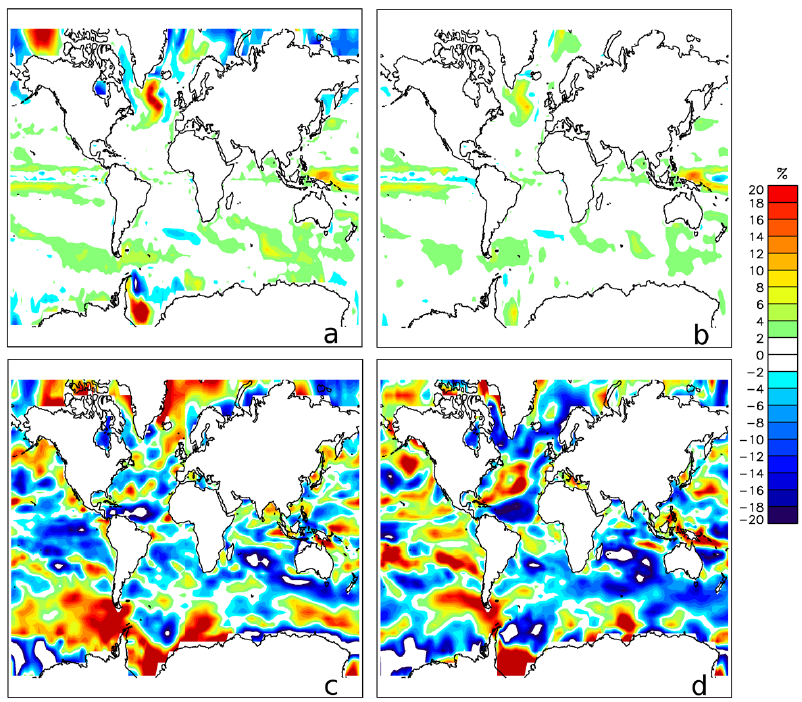
Fig. 10. Annual mean relative change in DMS emissions for (a) CLIM2 GW, (b) CLIM3 GW (with respect to CLIM2 and CLIM3), (c) CLIM1 1999, and (d) CLIM1 2001 (both with respect to